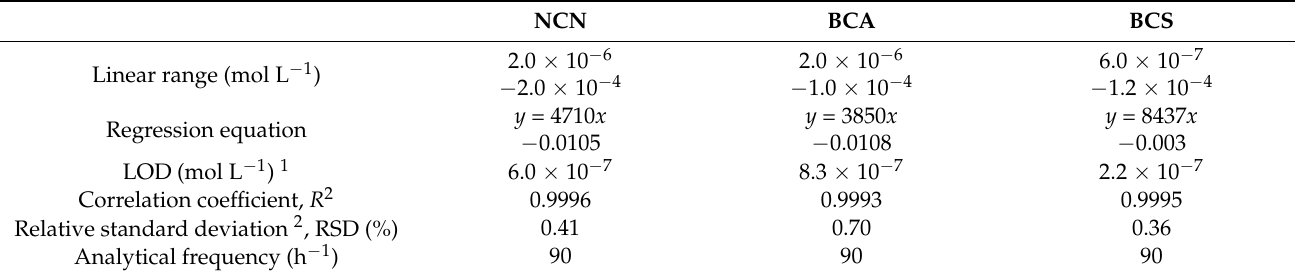
Table 2. Analytical characteristics of the developed FIA